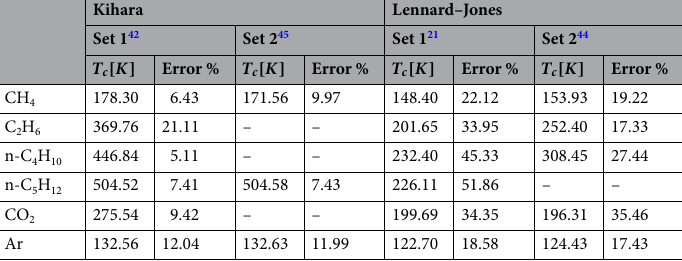
Table 3. Values of calculate bulk critical temperatures from Eq. (23) based on different literature reports of Kihara and L-J parameters for some fluids.